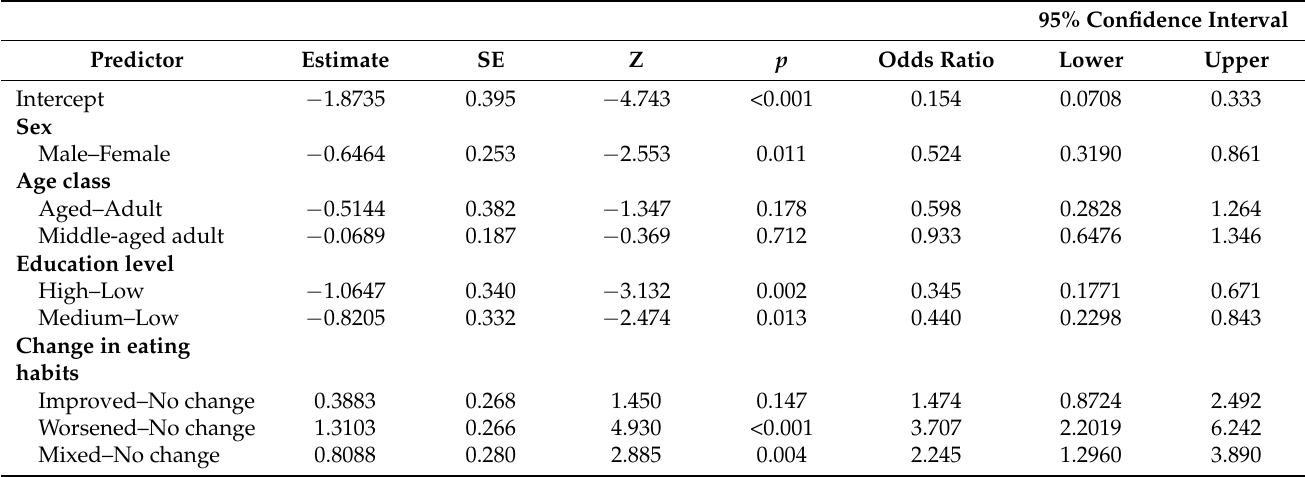
Table A3. Results of Multivariate Regression Analysis Models, with Quality of Sleep as Dependent Variable and Change in Eating Habits and Sociodemographic Characteristics as Independent Variables.